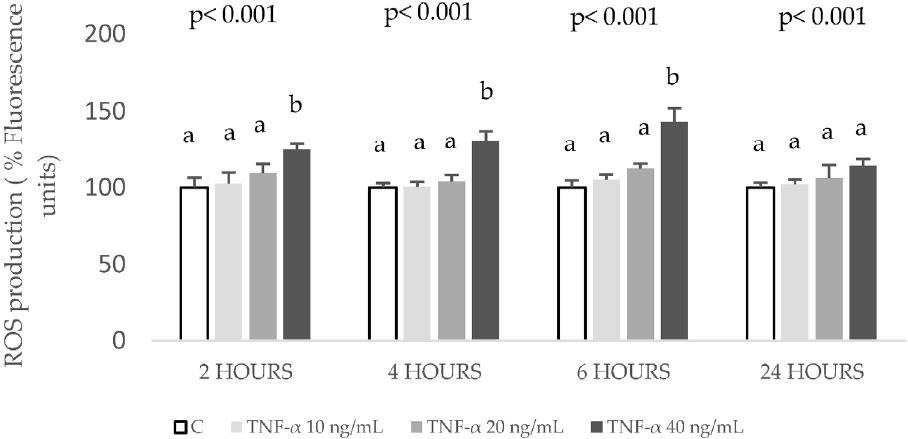
Figure 3. Effect of (TNF- α ) on reactive oxygen species (ROS) production in HepG2 cells. Concentra- tions of 0 (control, C), 10, 20, and 40 µM of TNF- α were added to HepG2 cultures and ROS levels were evaluated at the noted time points. Data are means ± SD of 4 different samples per condition. The p values above the figures represent ANOVA results and the different letters denote statistical differences according to the Bonferroni test within the same time point ( p < 0.05).